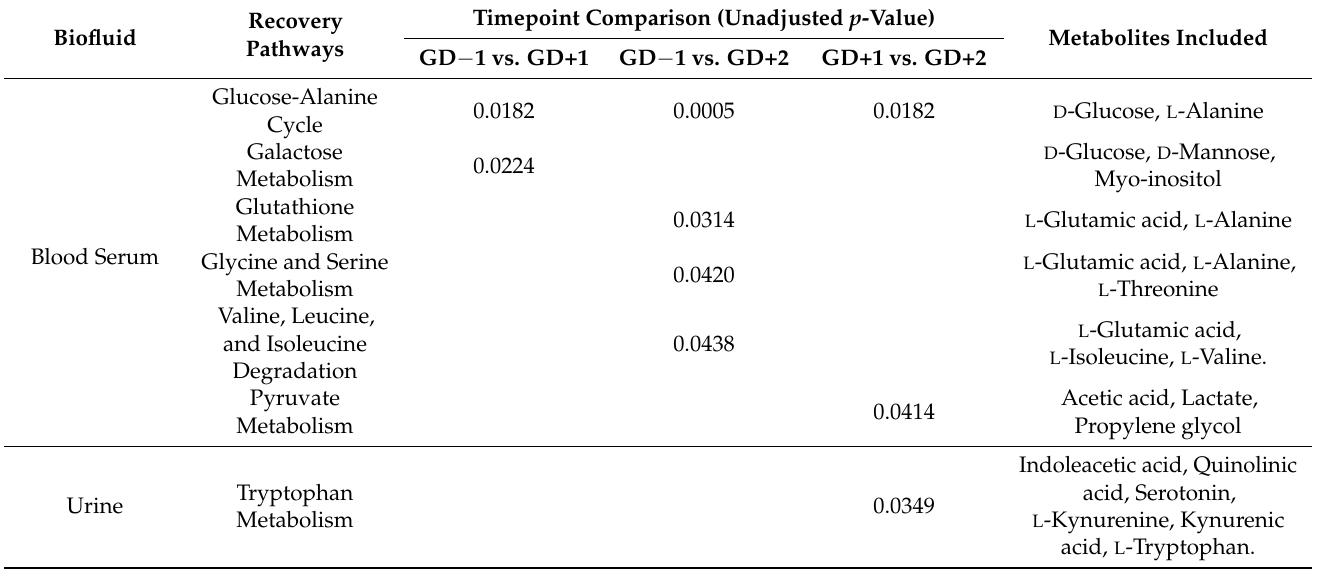
Figure 5. Potential mechanisms of tryptophan (TRP) metabolism and the kynurenine (KYN) pathway induced by exercise. Redrawn from [27] with additional information and the specific metabolites identified as key discriminators via PLSDA modelling in the acute post-match and recovery period. Kynurenate (KA); quinolinate (QA); oxidized form of nicotinamide adenine aminotransferase (NAD+); 3-hydroxykynurenine (3-HK); tryptophan 2,3-dioxygenase (TDO); indolamine 2,3-dioxygenase (IDO); kynurenine 3-monooxygenase (KMO); kynurenine aminotransferase (KATs); proliferator-activated receptor-gamma coactivator-1alpha (PGC-1 α ). Urinary metabolites identified via multivariate analysis are in bold. Figure created with BioRender. Table 2. Results of pathway enrichment analysis using the key discriminatory metabolites generated via PLSDA modelling. The unadjusted ranked p -values are displayed here.